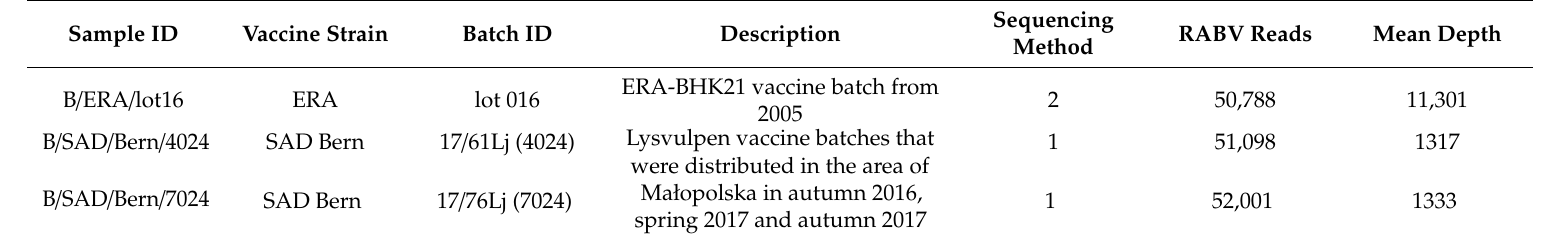
Table 2. Overview of ERA and Street Alabama Du ff erin (SAD) Bern vaccine batches analyzed in this study. Sample